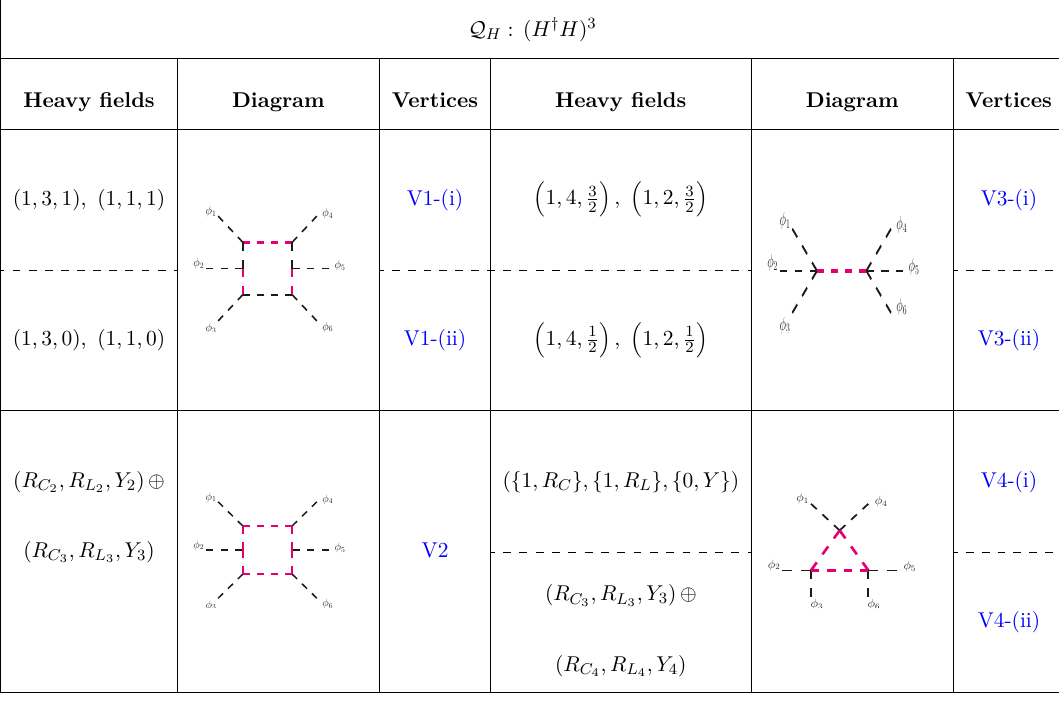
Table 5 . Heavy field representations that are obtained by unfolding the φ 6 operator into non-trivial tree- and (or) one-loop-level diagrams and the corresponding